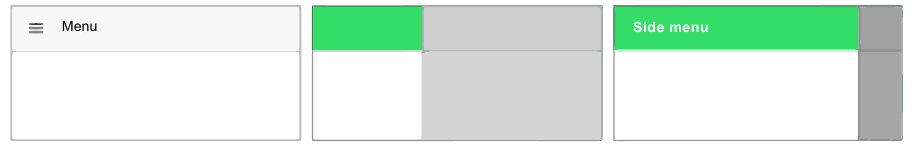
Figure 2. Example of a side-menu drawer opening